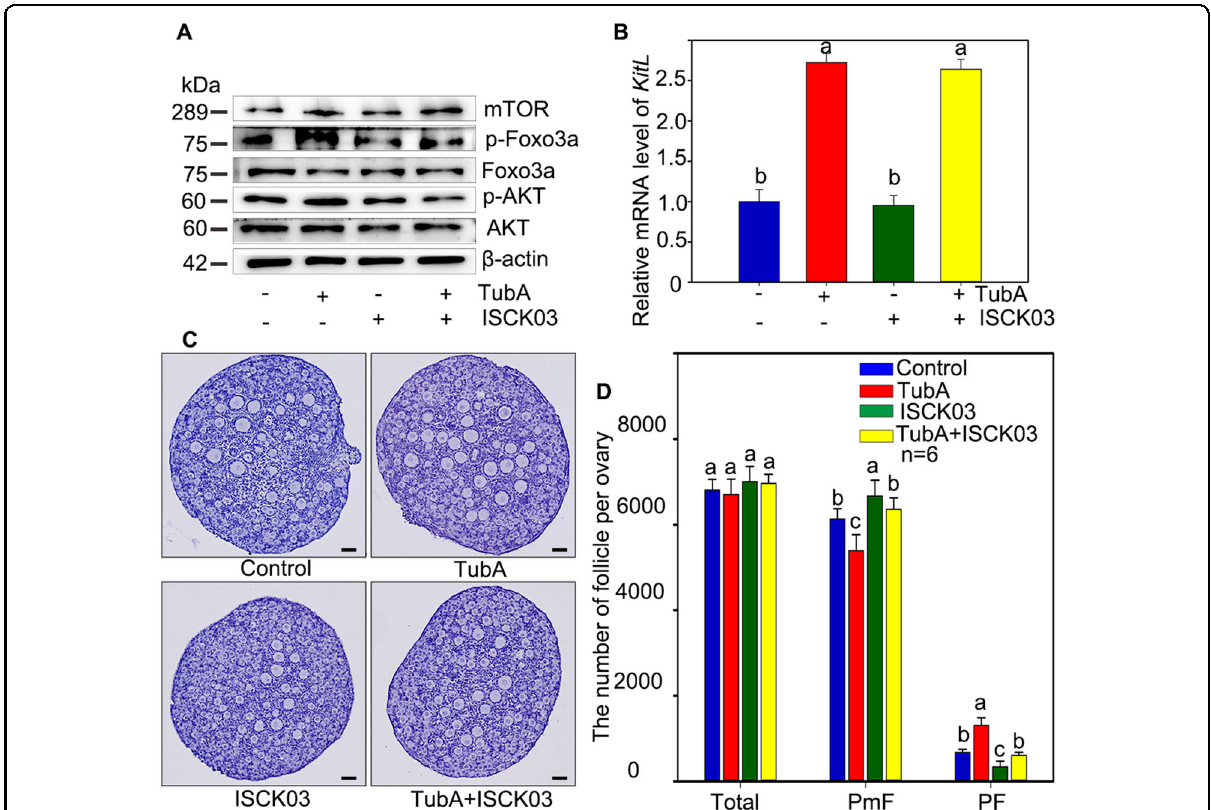
Fig. 6 HDAC6 regulated primordial follicle activation through mTOR-KITL signaling. A The western blotting results showed the protein expression of mTOR, p-Foxo3a, Foxo3a, p-AKT, and AKT in TubA group, ISCK03 group and TubA plus ISCK03 group, respectively. B The Kitl mRNA relative level in TubA group, ISCK03 group and TubA plus ISCK03 group, respectively. C , D The histological analysis and counting results showed that the primordial follicle activation was reversed in TubA plus ISCK03 treatment compared with TubA treatment. The experiments were repeated at least three times. And representative images are shown. The data are presented as the means ± SEM. Scale bars: 50 μ